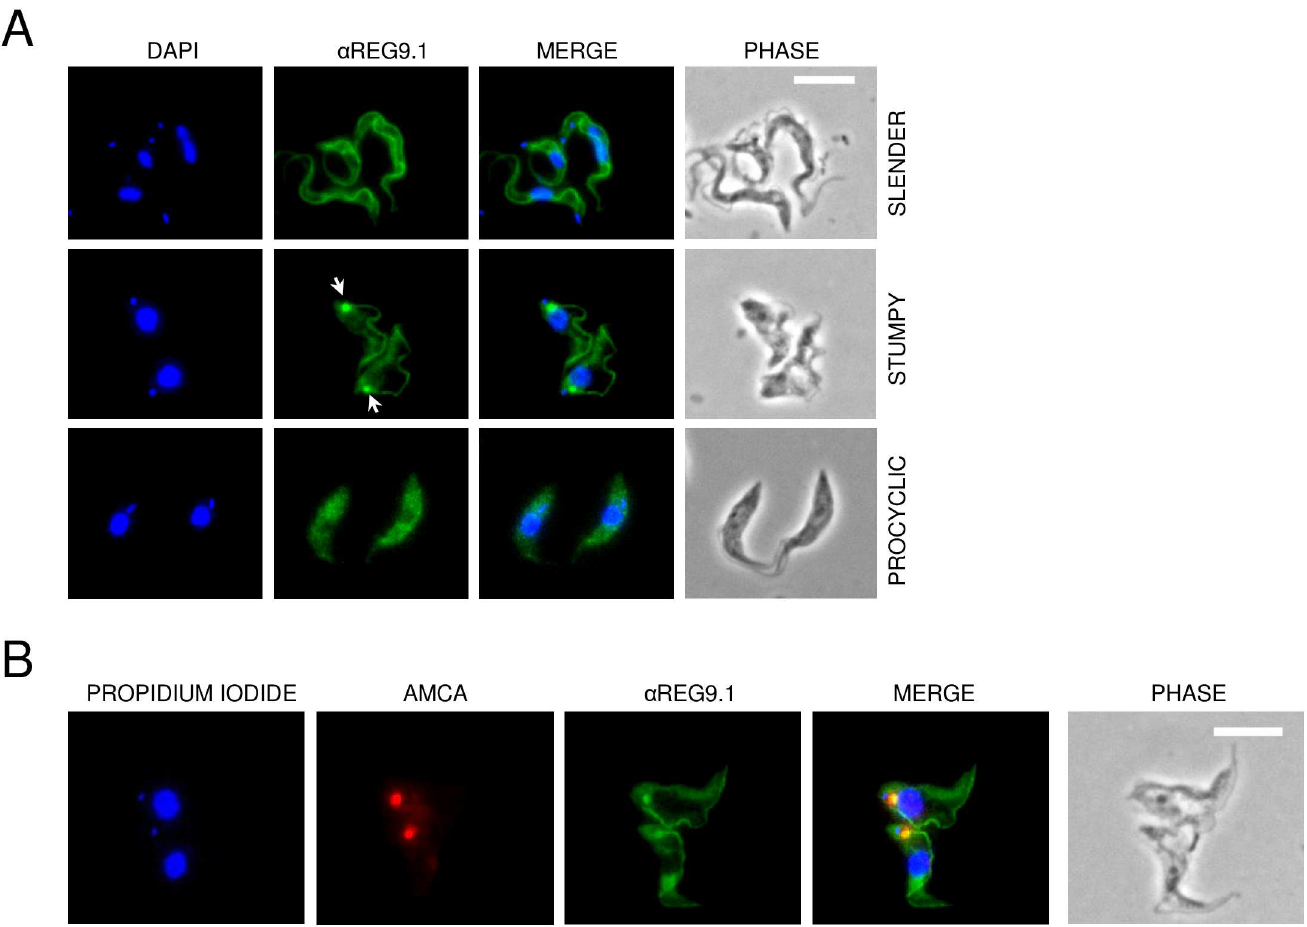
Fig 9. Differential cellular location of REG9.1 in the trypanosome life cycle. A. Cellularlocation of REG9.1 in slender, stumpy and procyclic forms. Kinetoplastand nuclearDNA was visualisedwith DAPI staining(pseudocoloured blue), whereasthe cell outline was visualisedvia Phase contrast microscopy. The REG9.1 signalis cytoplasmic in slender and procylic forms but concentrated at the cell posterior in stumpy forms (arrowed). Bar = 10 μ m.B. Co stainingof two stumpy cells with REG9.1 (Green), AMCA (Red, stainingthe flagellarpocket) and propidiumiodide(pseudocoloured Blue, staining the nucleusand kinetoplast). The REG9.1 stainingis close to but not coincident with the AMCA stainingat the flagellarpocket.